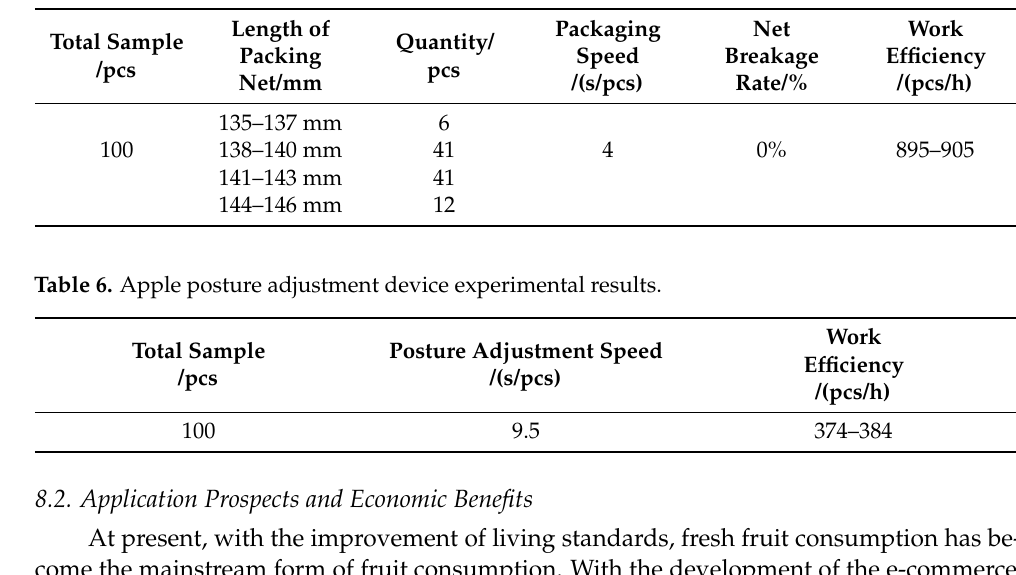
Table 5. Net device experimental results.